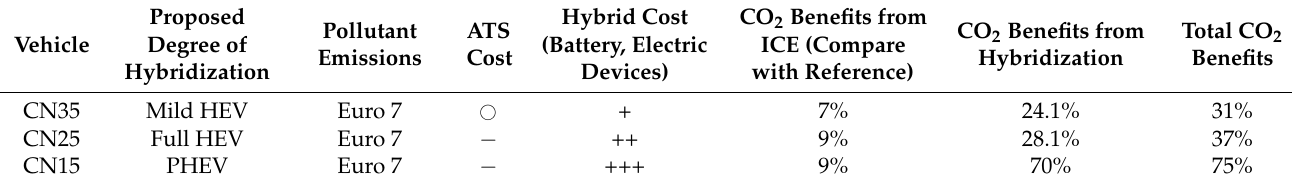
Table 3. Summary of HEV simulation results and cost estimation of the proposed GCI hybrid vehicles ( − low cost, cost like reference, + high